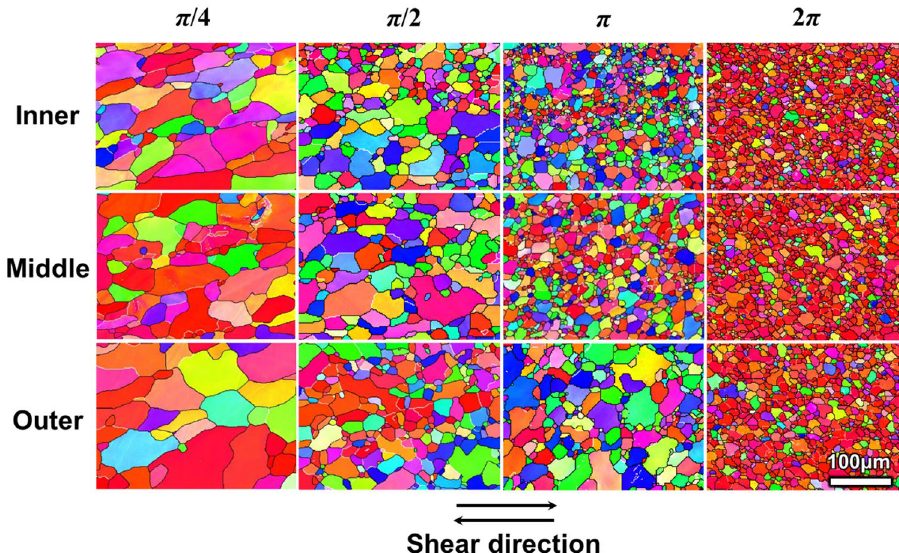
Figure 4. EBSD IPF maps from inner (top), middle (center) and outer (bottom) regions as indicated in Fig. 1 of the 5N Al processed by t -HPS to a rotation angle of π/4 (left), π/2 (center left), π (center right) and 2π (right). The scale bar is the same for all the IPF